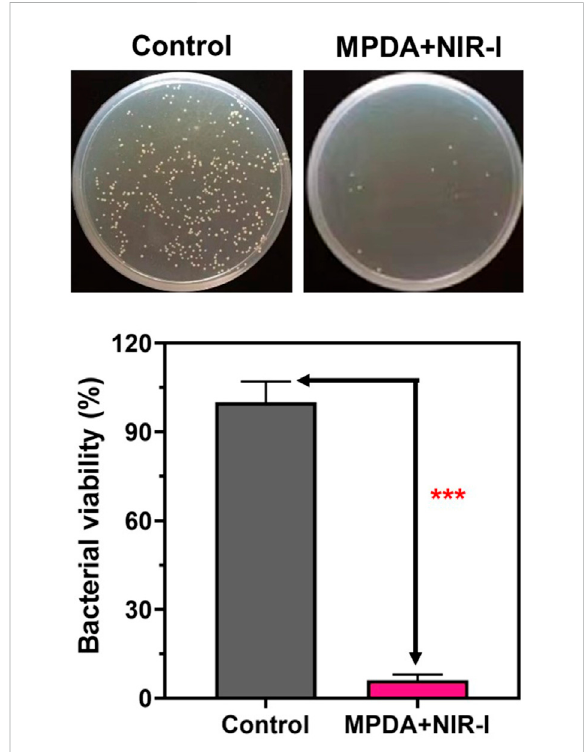
Antibacterial activity of MPDA in vitro . Typical agar plate photographs of bacterial colony formed by S. aureus after processing by MPDA (200 μ g ml − 1 ) with and without NIR-I (808 nm, 1 W cm − 2 , 6 min). Corresponding quantitative data of S. aureus survival rate after different treatments determined by standardplatecountingmethod.Dataarepresentedasmean±SD ( n = 3), *** p <